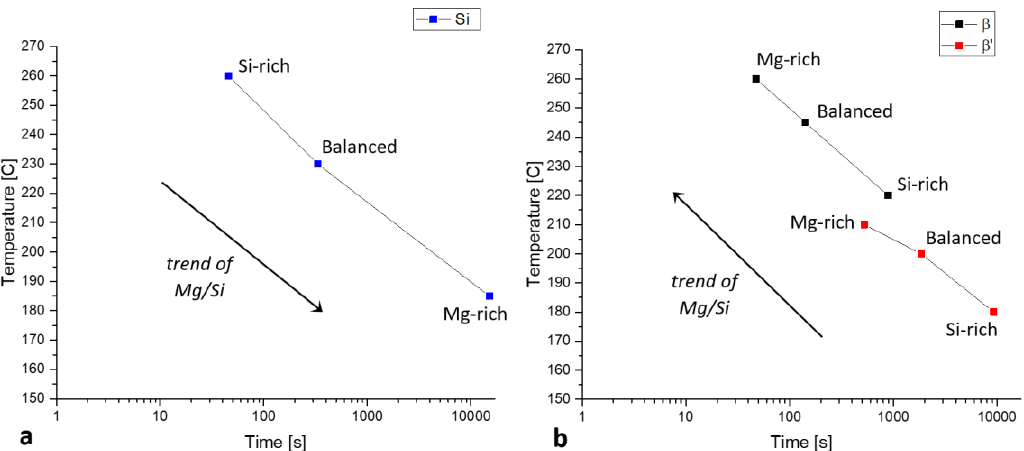
Figure 19. Data points corresponding to the nose of simulated (Thermo-Calc/Prisma [56]) time– temperature–transformation (TTT) curves (for the depletion of 10% of equilibrium volume fraction), for various compositions in the Al-(Mg + Si = 1.4) − 0.2Fe − 0.05Mn (wt%) system. Data point labels correspond to Mg/Si (by wt%), and Mg/Si trend arrows are included. Simulated precipitates are separated by composition trend, pure Si precipitate in ( a ), and β and β’ in ( b ).